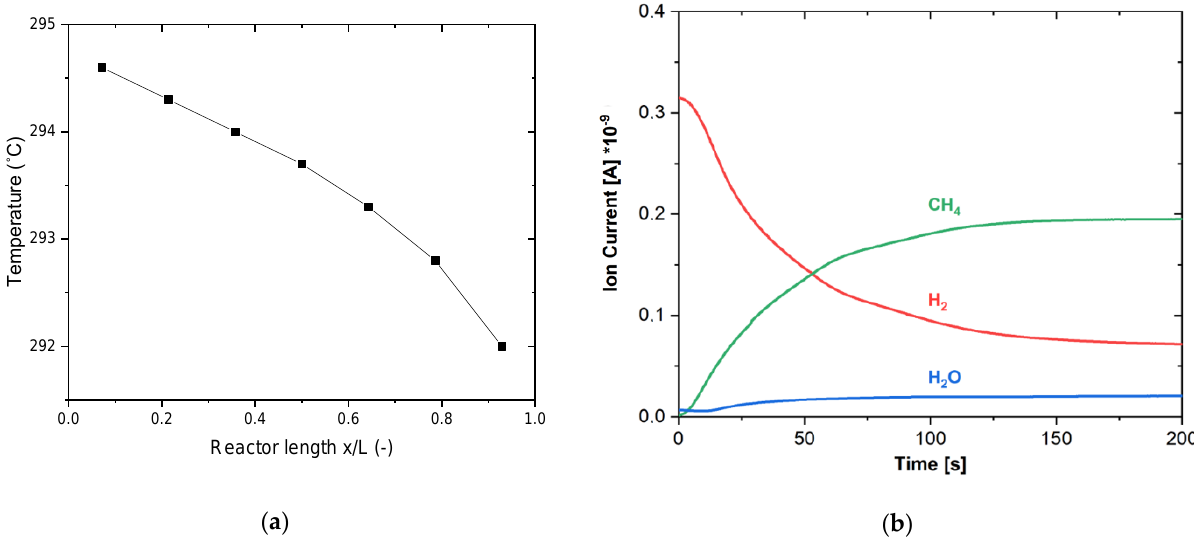
Figure 11. ( a ) Axial temperature profile at steady state and ( b ) Ion current change over time for the main species in the Sabatier reaction. Experimental conditions: total gas flow: 20 mL/min, H 2 :CO 2 = 4:1, P = 1 bar, baseline temperature = 290 °C.